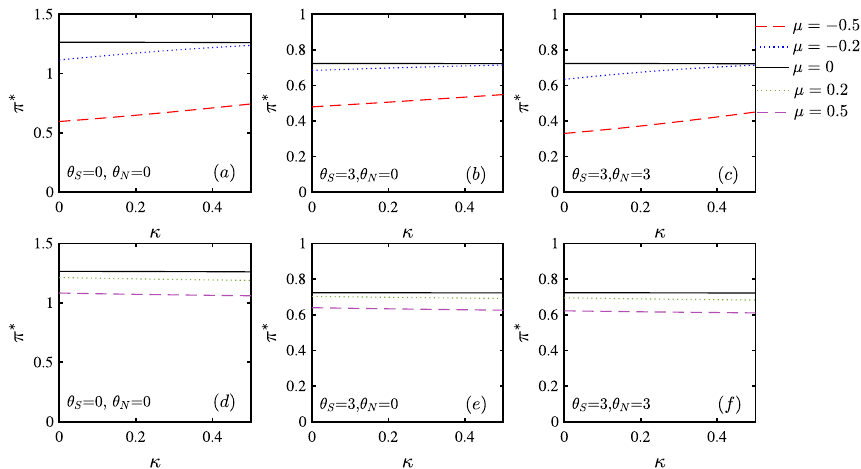
Fig. 4 Effects of price and volatility jump sizes on portfolio choice in stock market. The top three panels show downward price jumps and no jump, while the bottom three panels show upward price jumps and no